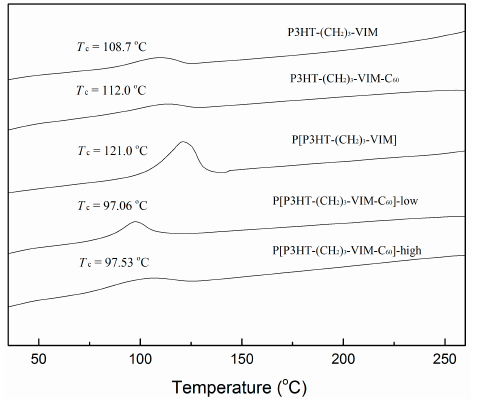
Figure 15. DSC curves showing crystallization temperatures of macromer P3HT-(CH 2 ) 3 -VIM, brush polymer P[P3HT-(CH 2 ) 3 -VIM], and their C 60 adducts.